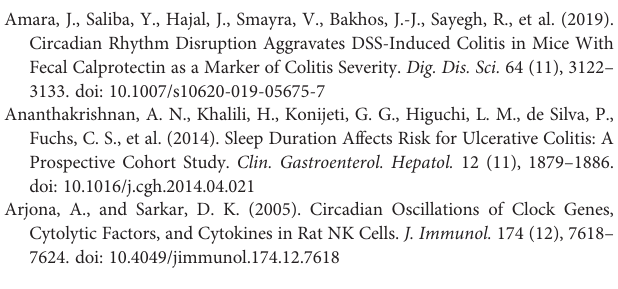
Supplementary Table 1 | Summary of Antibodies and Staining Protocols. Supplementary Table 2 | List of Primers Sequences. Supplementary Table 3 | Summary of Statistical